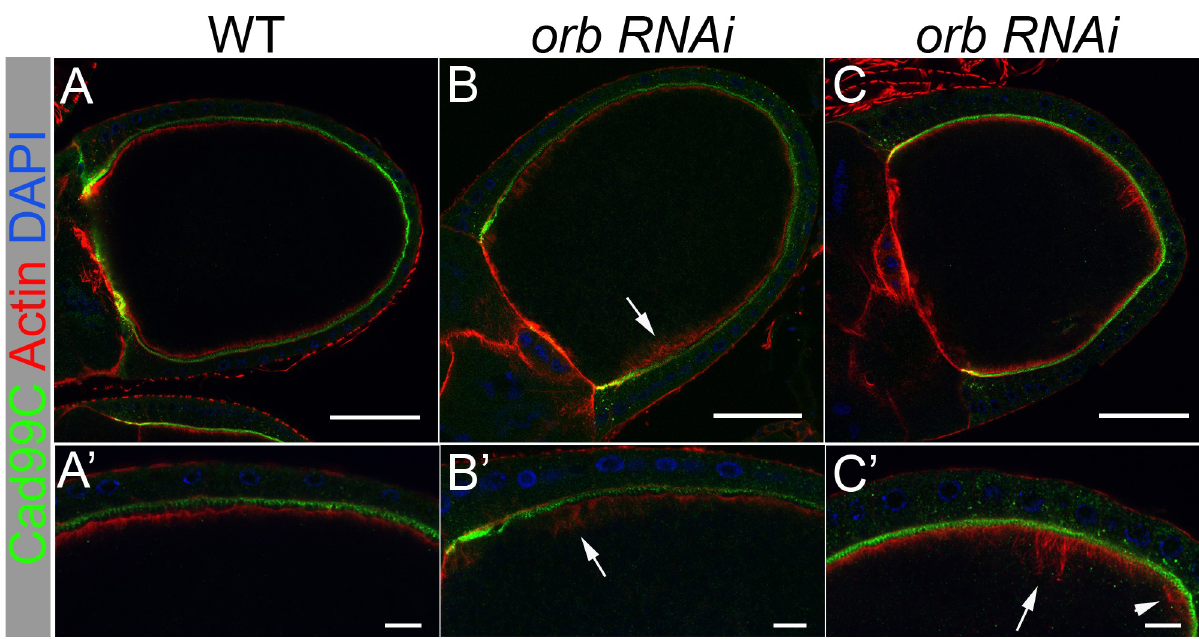
Fig 7. The oocyte actin cytoskeleton is not maintained in orb . Egg chambers are stained with Cad99C (green), which labels the apical microvilli of the somatic follicle cells, and Phalloidin (red), which labels Actin on both the apical side of the follicle cells and the oocyte cortex, and DAPI (blue). (A and A’) Wild type organization of Actin along the oocyte cortex (n = 16). (B and B’) Defects in Actin organization in orb mel /orb 343 are observed in 72% of oocytes stages 9–11 (n = 18). (C and C’) Defects in actin organization when orb RNAi (#64002) is expressed during mid-stages of oogenesis (maternal α - tubulin Gal4, #7062) are observed in 65% of oocytes stages 9–11 (n = 20). We also observed a defect in actin structure at a frequency of 70% in HD19 , 343/mel oocytes stages 9–11 (n = 10). Arrows point to defects in cortical actin organization as described in the text. Top panel scale bars are 50 microns; bottom panel scale bars are 10